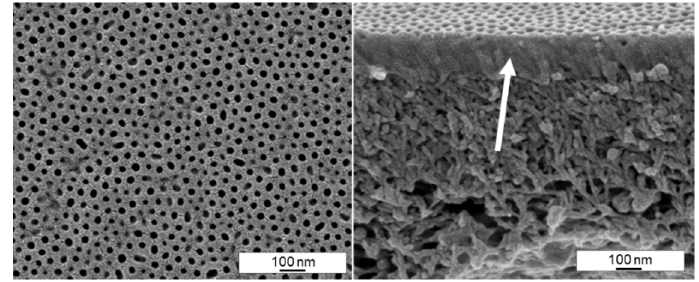
Figure 15. SEM images of spray cast samples of PS 83 - b -P4VP 1788 solution in dioxane (1 wt%) with a 2-fluid nozzle and different evaporation times (from 3 to 23 s), p(G) = 1.8 bar gas, p(L) = 2.2 bar, d(NS) = 15 cm, d(NN) = 4 cm.